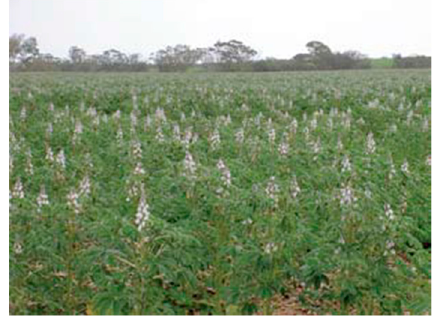
Figure 3. Lupinus albus (withe lupin) Photo: Figura 3 . Lupinus albus (withe lupin) Photo: B.Buirchell Figura 3 . Lupinus albus (withe lupin) Photo: B.Buirchell Figura 3 . Lupinus albus (withe lupin) Photo: B.Buirchell